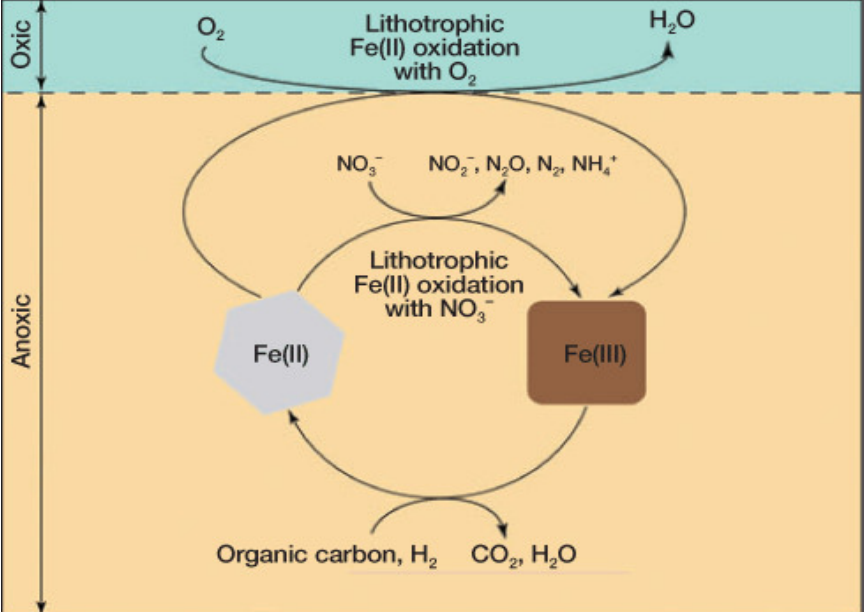
Figure 5. Iron frequently cycles rapidly between redox states, especially in wetland soils, because it is frequently used as an elector acceptor or donor in decomposing organic matter. Fe also reacts geochemically with minerals and reduction can be facilitated by humic substances that act as electron shuttles in the reduction of insoluble iron oxides. Reduced Fe (II) is then re-oxidized back to Fe (III) in contact with O 2 or anaerobically via several biogeochemical processes or with nitrate possibly being reduced to several species (N 2 , N 2 O, NH 4+ , NO 2 − ). Fe cycling thus acts as a ferrous wheel. Source: [38]. Reproduced with permission from J. Wiley & Sons.